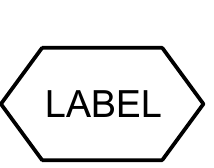
Figure 2.37: The Process Description glyph for phenotype .